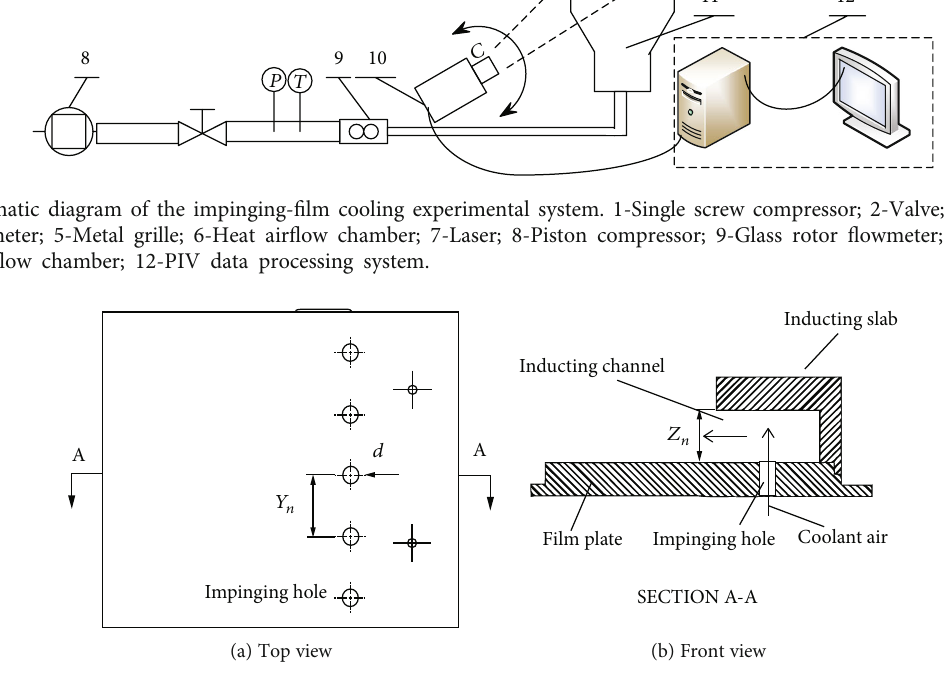
Figure 4: Schematic structure of an impinging- fi lm cooling test